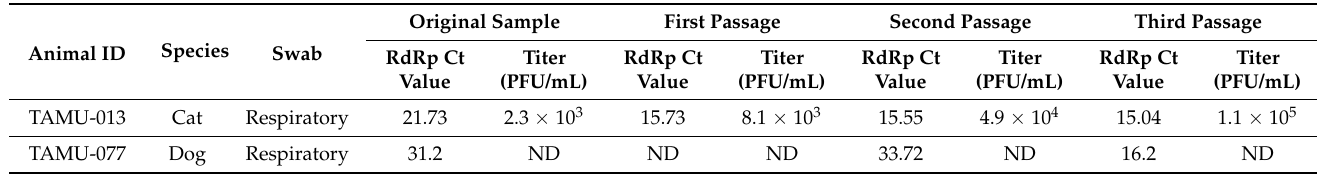
Table 2. Pets with positive isolation for SARS-CoV-2. The Ct value for RdRp qRT-PCR and viral titer is shown following each of three passages on Vero cells. Work conducted at Biosafety Level 3 Facility at Texas A&M University.